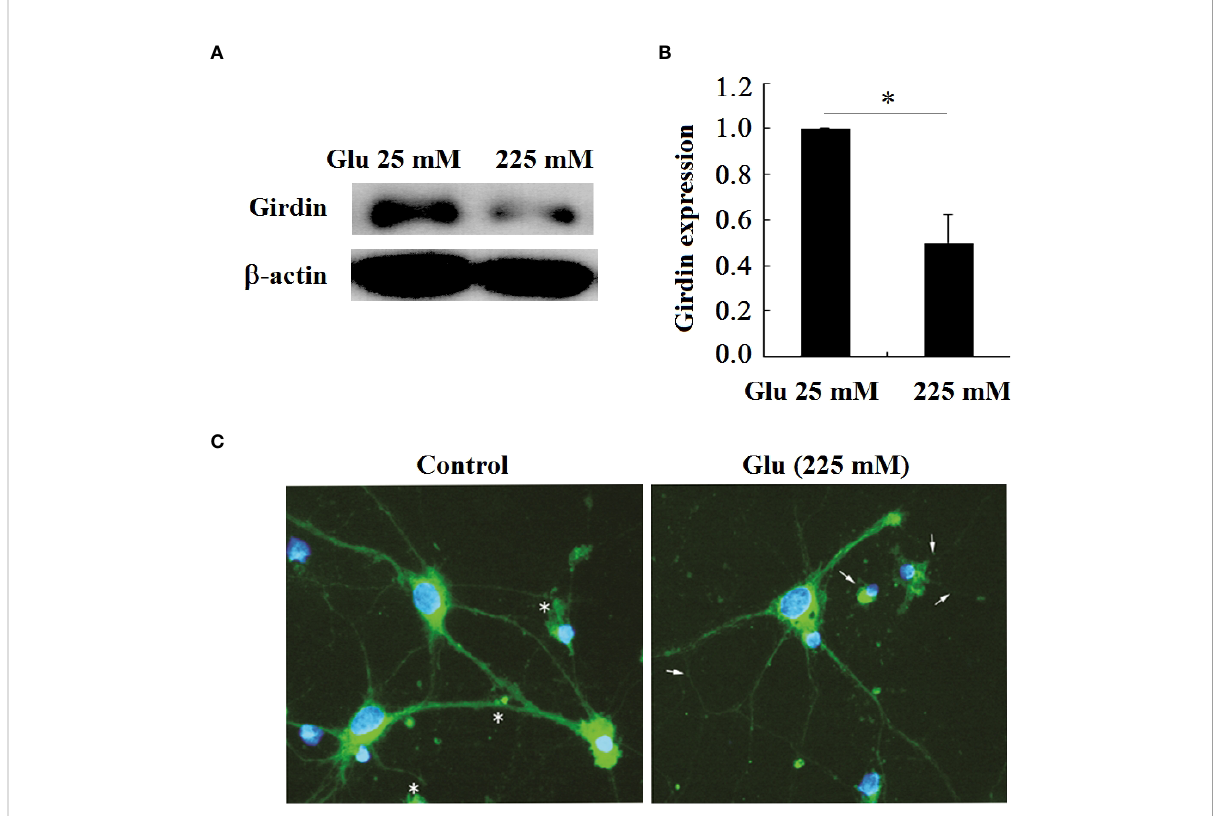
FIGURE 8 Girdin expression in hippocampal neurons decreased under high glucose stimulation, * P < 0.05. (A) Western blot to detect the expression of Girdin. (B) Grayscale analysis of Girdin expression. (C) Immuno fl uorescence analysis of Girdin expression under high glucose stimulation (×400). The arrow refers to the Girdin